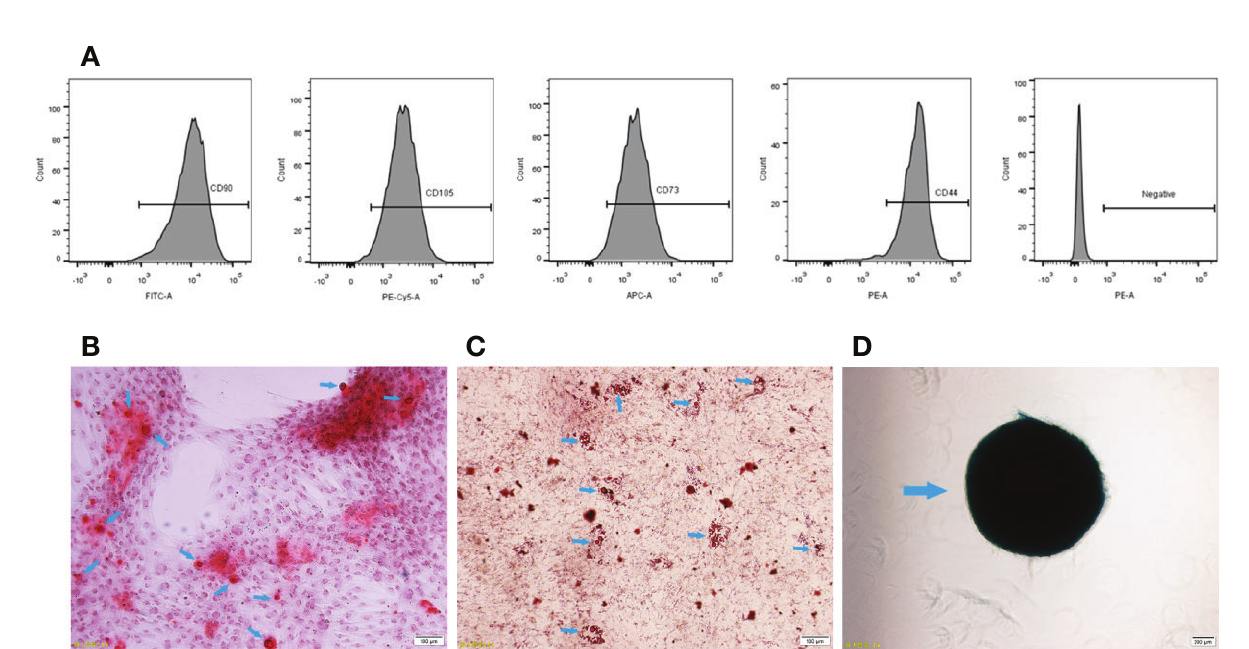
FIGURE 1 | Characterization of UCMSCs. (A) Representative fl ow cytometry histograms showing high expression levels of CD105, CD90, CD44, and CD73 and low expression levels of the negative MSC cocktail (CD45/CD34/CD11b/CD19/HLA-DR) on the surface of UCMSCs. (B) Osteogenesis. Red calci fi ed nodules formed after 7 to 10 days of osteogenic induction (Alizarin red staining, see arrows). (C) Adipogenesis. Orange red lipid droplets in the cytoplasm after 21 days of adipogenic induction (oil red O staining, see arrows). (D) Chondrogenesis. Proteoglycan aggrecan in mature chondrocytes was stained blue after 21 days of chondrogenic induction (Alcian blue staining, see arrows). Scale bar = 100 m